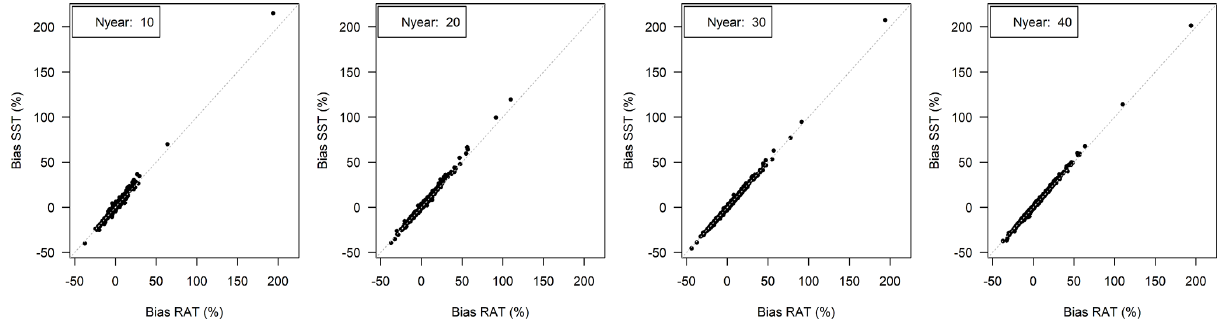
Figure A4. Annual bias obtained with the RAT procedure vs. annual bias obtained with leave-one-out SST. Shorter time periods are obtained by sampling 10, 20, 30 and 40 years regularly among the complete time series. Each of the 21 catchments is represented with annual bias values.